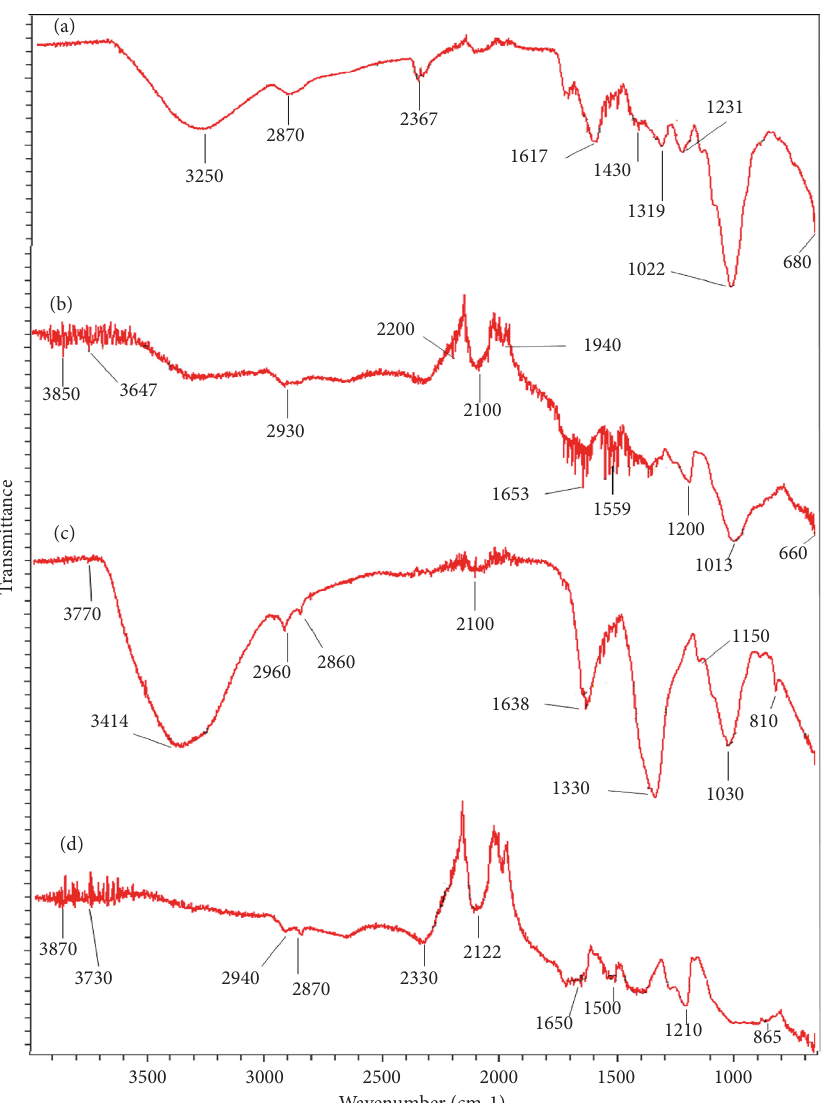
Figure 4: FTIR spectra of untreated and citric acid-treated peels before the adsorption of dye (BGD). (a) R-TNP, (b) CA-TNP, (c) R-CLP, and (d)